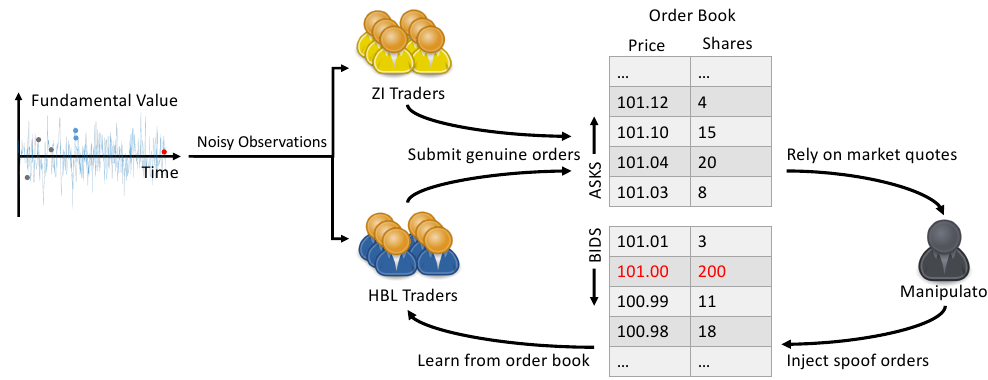
Figure 2. An agent-based model of spoofing a CDA market with a single security